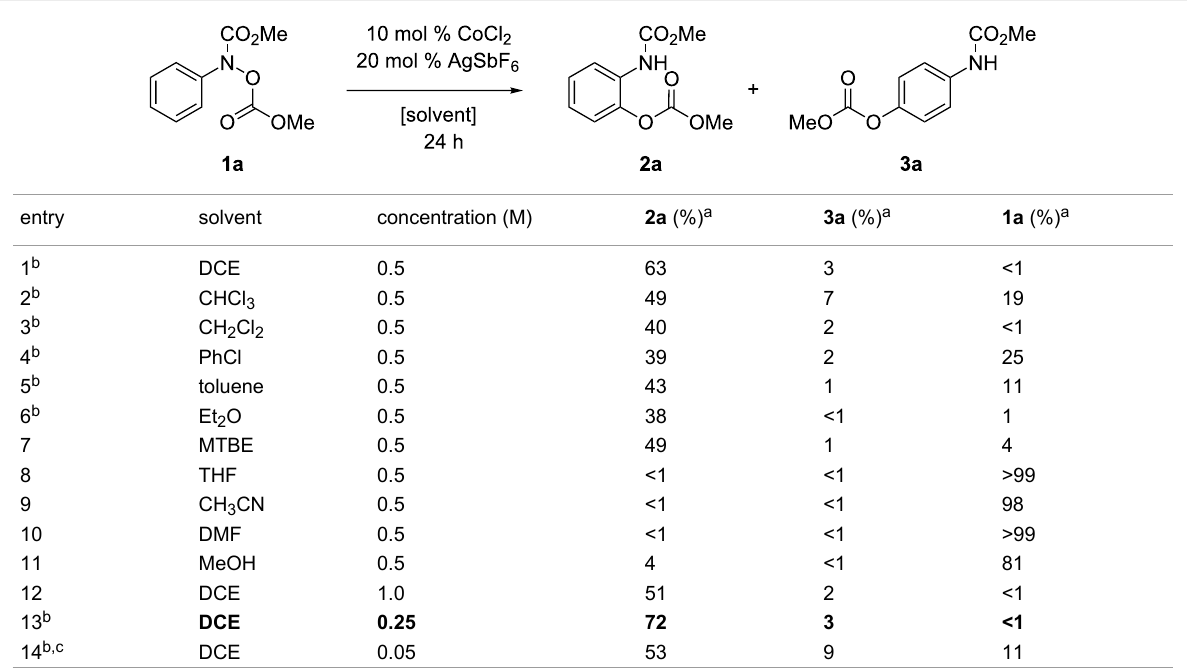
Table 2: Solvent and concentration